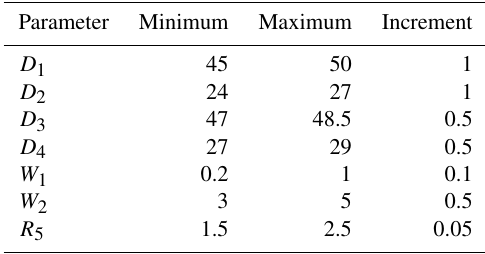
Figure 3. The designed parallelogram-like structure based elastic element. Table 2. Search space for the optimization of the proposed parallelogram-like topology